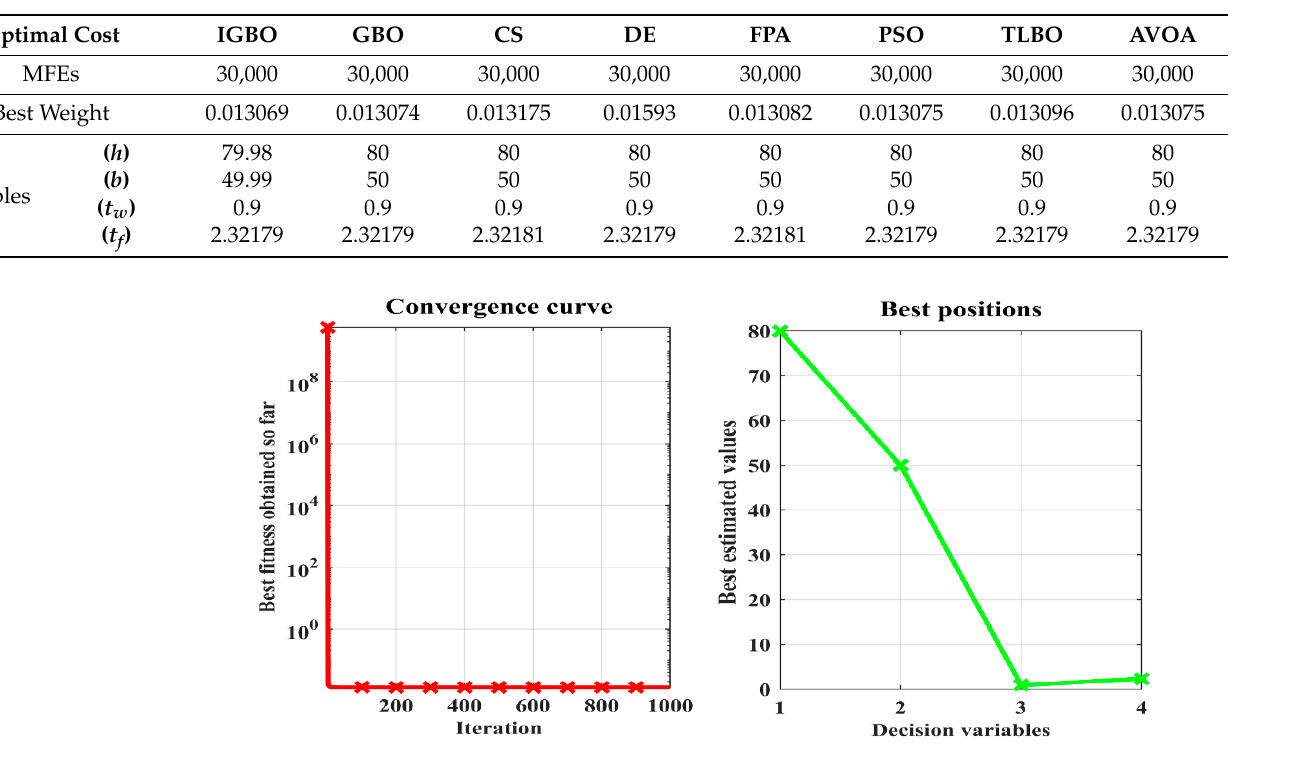
Figure 10. Convergence curve and best positions of I-beam design using IGBO.